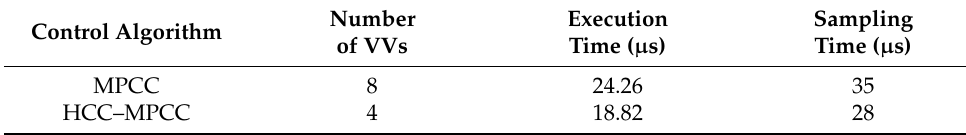
Table 4. VV number and execution time of HCC–MPCC and classical